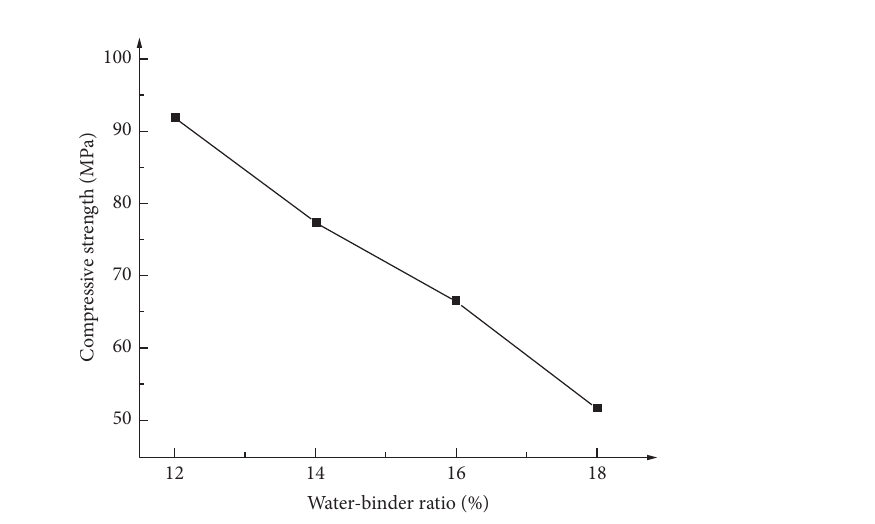
Figure 6: Water ratio-compressive strength curve.